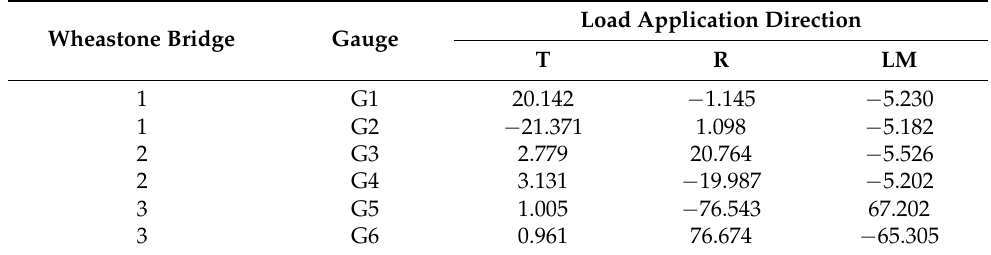
Table 1. Microdeformations measured by the gauges when applying a force of 98.1 N in each direction. Wheastone